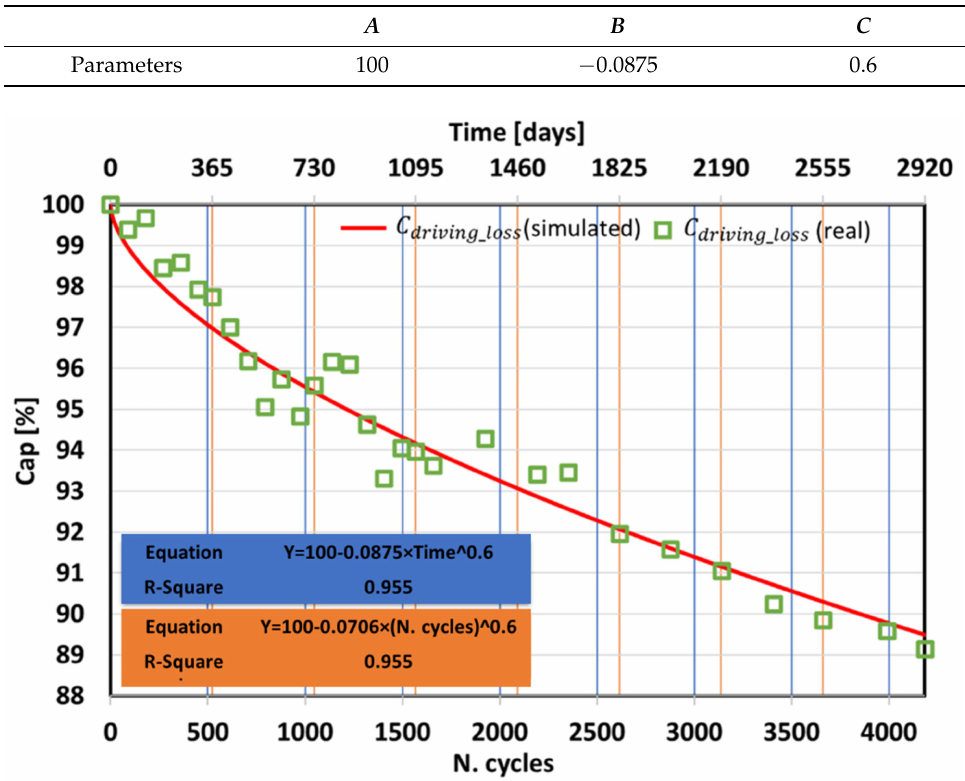
Table 10. Fixed parameters of the fitted function (2).